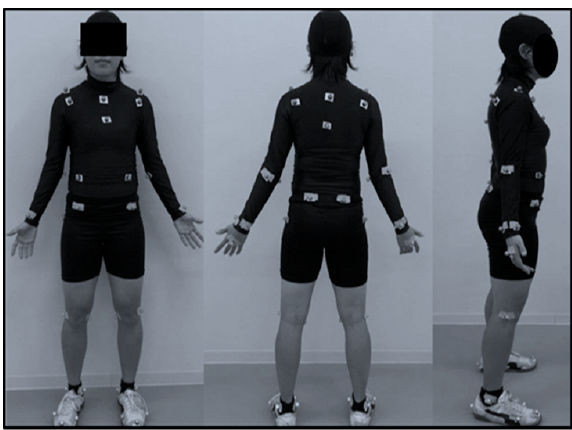
Figure 2. A total of 47 reflective markers were placed on each subject.